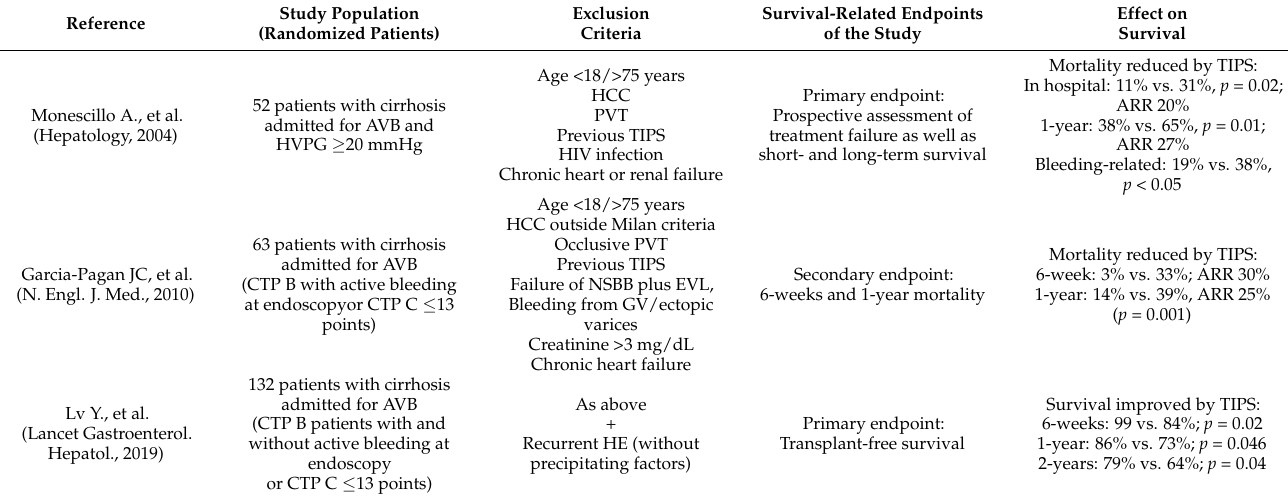
Table 1. RCTs assessing pre-emptive TIPS vs. endoscopic treatment in acute variceal